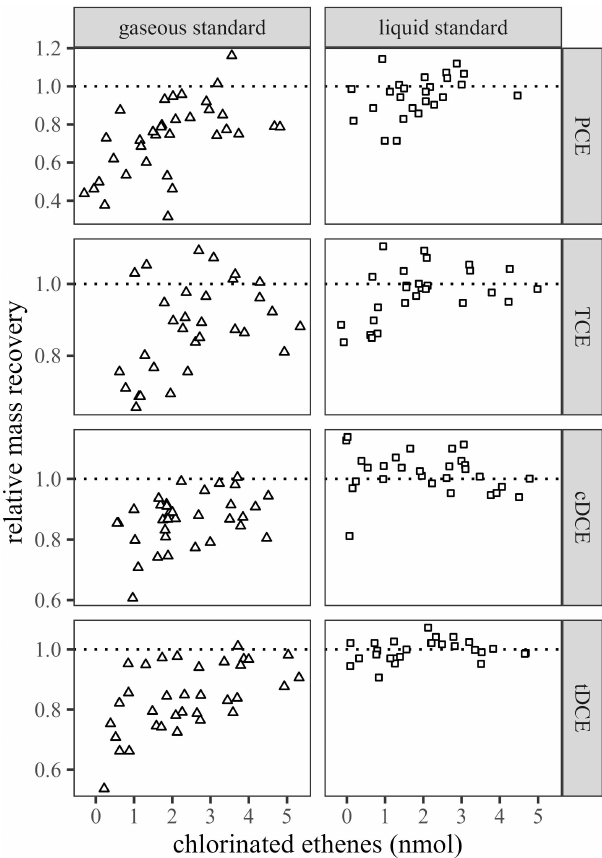
Figure 3. Relative mass recovery rates of PCE, TCE, cDCE and tDCE when measured by the presented thermal desorption method after loading of gaseous or liquid calibration standard aliquots over the calibration range of chlorinated ethenes